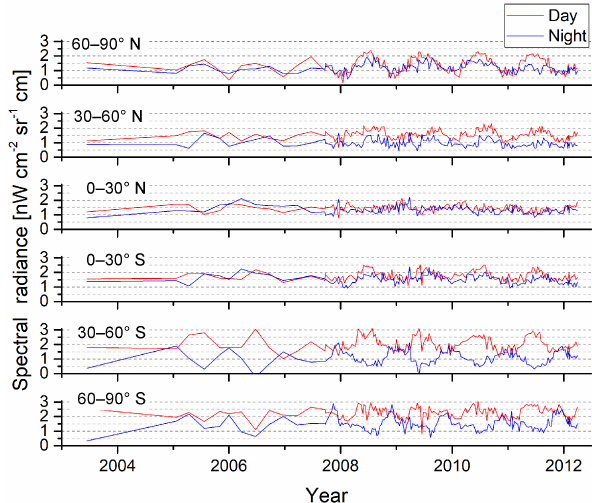
Figure 14. Mean offset over 100 to 170km tangent altitude in band A, separated in six latitude bands and separate for day (red) and night